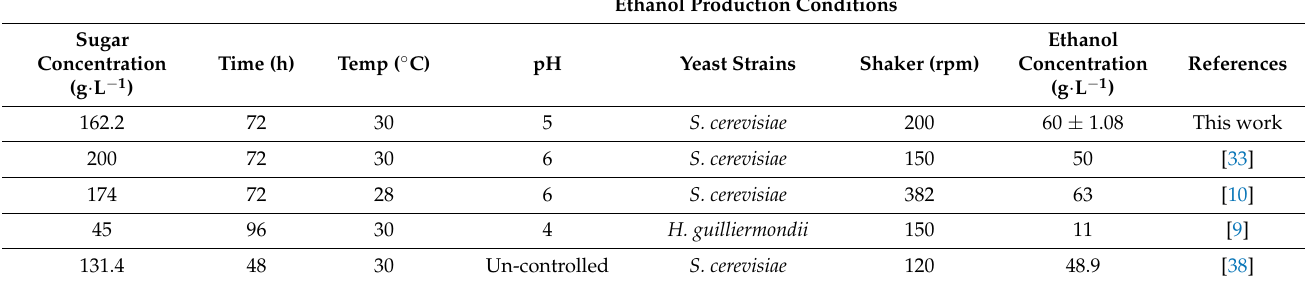
Table 3. Various conditions for ethanol production from dates and comparison with previously published